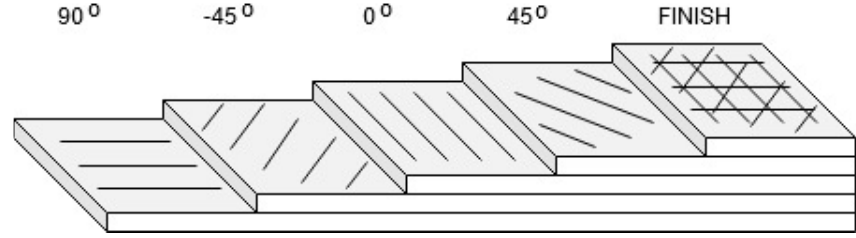
Figure 1. Plies in a stacked composite [0°/±45°/90°]